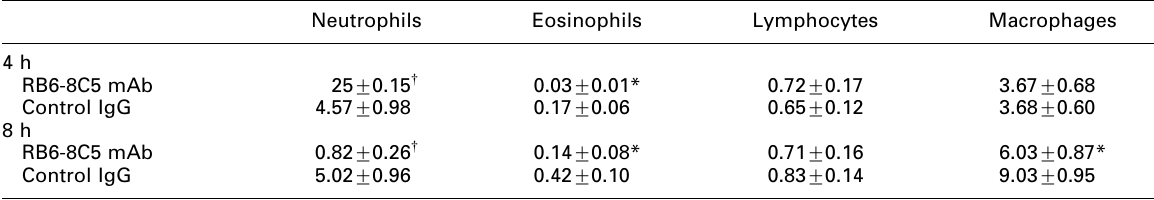
Table 1. Thioglycollate-induced leukocyte infiltration in granulocyte-depleted